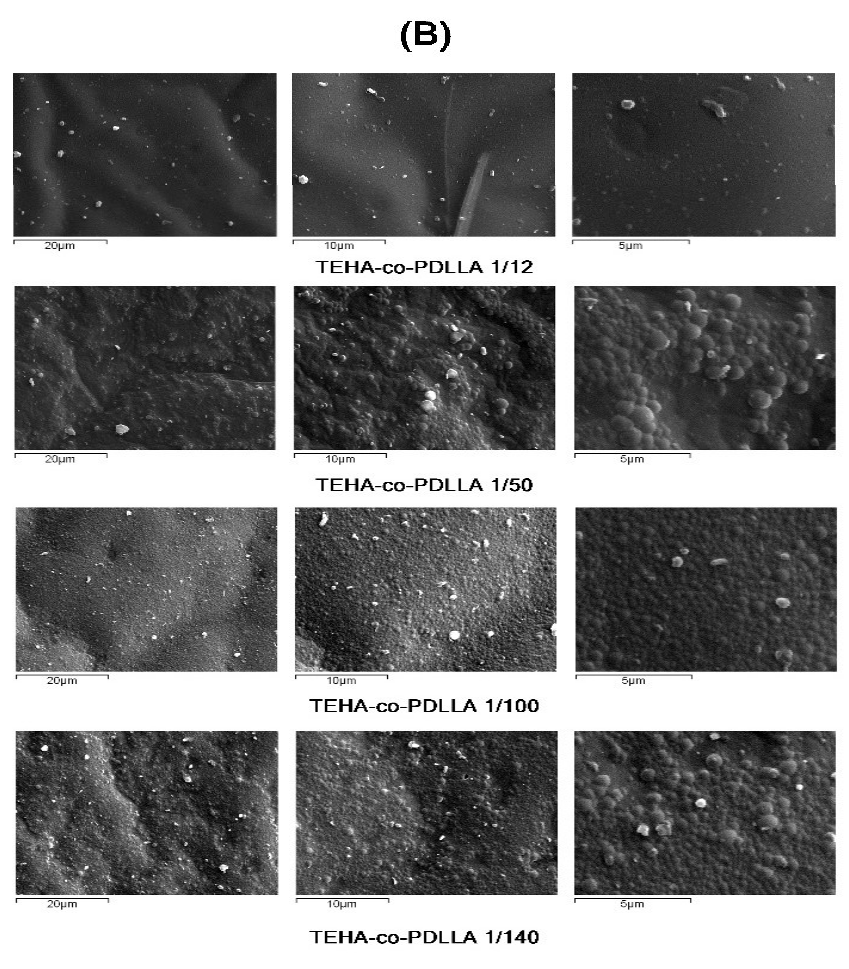
Figure A1. SEM micrographs of ( A ) prepared neat nanoparticles having PVA 0.5 w / v (i) or sodium cholate hydrate 12 mM (ii) in the aqueous phase and ( B ) prepared neat nanoparticles having PVA 0.5 w / v in the aqueous phase at varying TEHA to PDLLA ratios.